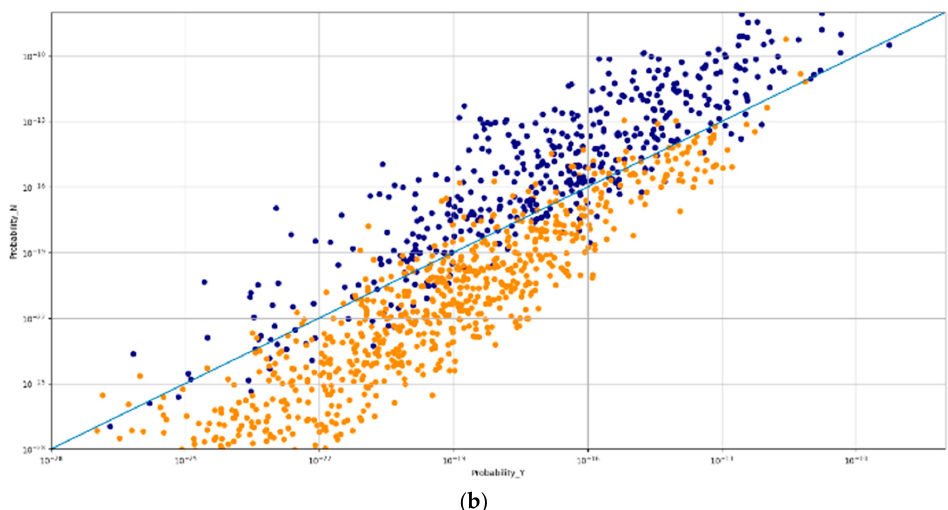
Figure 6. ( a ) The visualization of whole dataset by Naïve Bayes. The horizontal axis indicates the probability that the sample is 90 + , and the vertical axis indicates the probability that the sample is type 90 − ; ( b ) Magnification of Figure 6a.